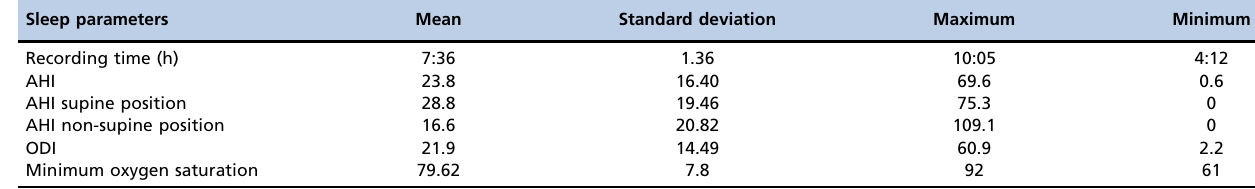
AHI: apnea-hypopnea index. ODI: oxyhemoglobin desaturation